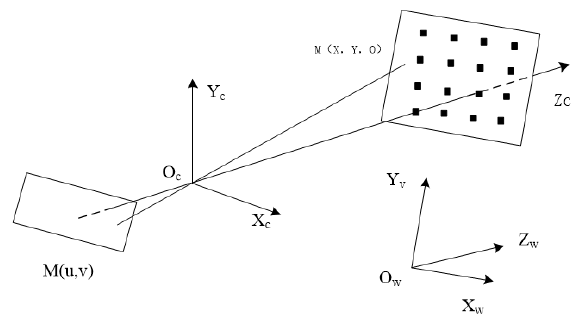
Fig. 2. Flow chart.